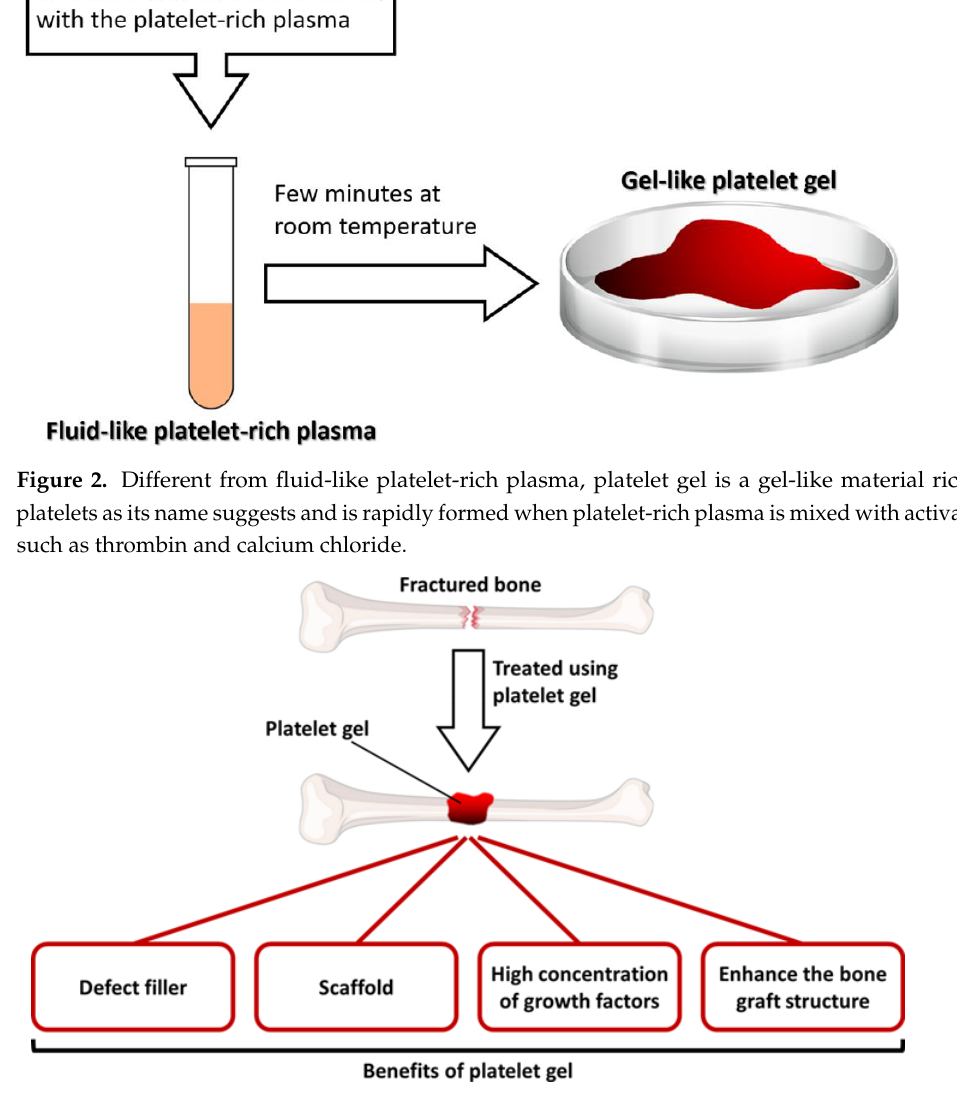
Figure 3. Illustration of advantages of platelet gel on reconstructing bone defects and nonunions. Table 1. Summary of advantages of platelet gel on reconstructing bone defects and nonunions.